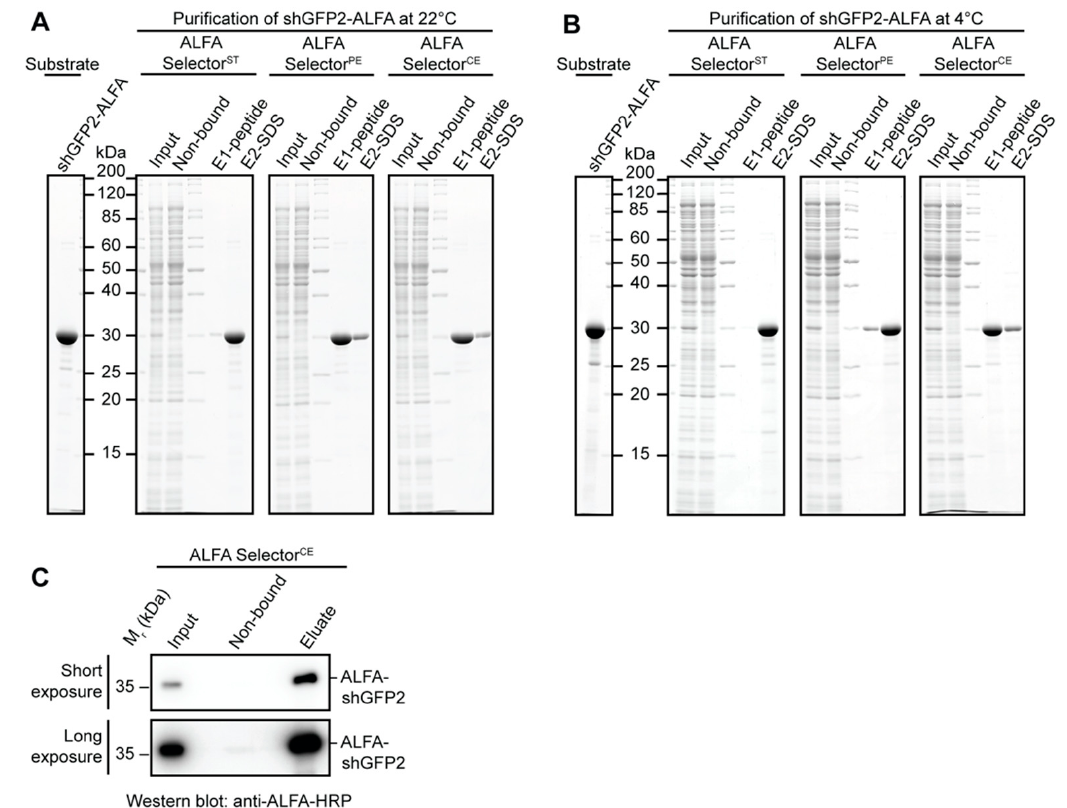
Figure 3. Affinity purification of ALFA-tagged proteins from complex lysates. ( A , B ): An E. coli lysate was blended with 3 µ M recombinant purified shGFP2-ALFA ( A , B ) and incubated with ALFA Selector ST , ALFA Selector PE or ALFA Selector CE . After washing, charged resins were eluted with 200 µ M ALFA peptide at 22 ◦ C ( A ) or 4 ◦ C ( B ) (E1-peptide). For all Selectors, remaining proteins were subsequently eluted with hot SDS sample buffer (E2-SDS). Amounts loaded in the SDS-PAGE for all eluate fractions correspond to the material eluted from 1 µ L of Selector resin. Images show gels after staining with Coomassie Brilliant Blue. ( C ): One-step affinity purification of low-abundant proteins using ALFA Selector CE : 50 mL of HeLa lysate containing 100 nM ALFA-shGFP2 was passed over 1 mL of ALFA Selector CE at room temperature using gravity flow. After washing, the column was eluted with PBS containing 1 mM ALFA peptide. Fractions were pooled and analyzed by SDS-PAGE and Western blotting. Amounts loaded correspond to 1/20,000 of the input and flow-through material and 1/2000 of the eluate. Shown is a representative blot after short (upper panel) and long exposure (lower panel). Full blots are shown in Figure